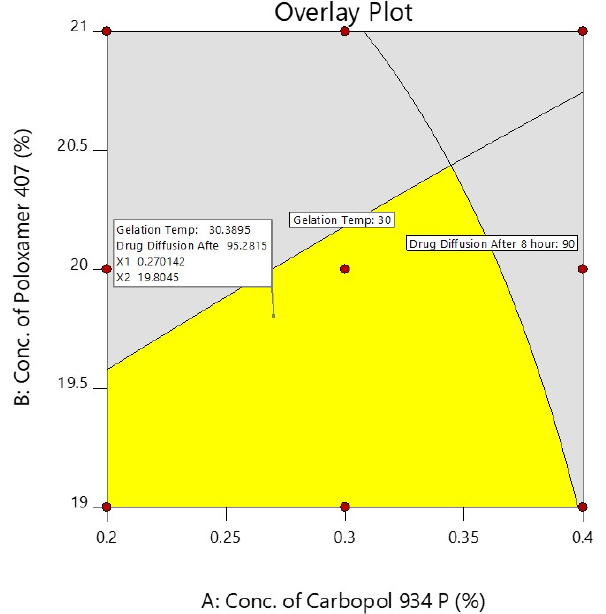
Figure 6. Overlay plot of independent factors and their responses.